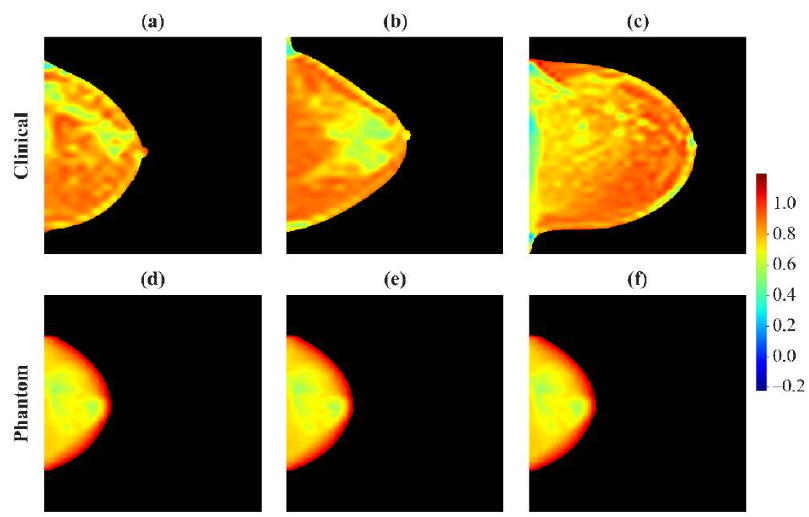
Figure 5. Heat maps for a robust feature (a Gabor Wavelet feature, CMV = 0.11) used as an example in Figure 1a. Top row: Clinical images at the ( a ) 5th, ( b ) 50th, and ( c ) 95th percentiles of the distribution in Figure 1a. Bottom row: Phantom images derived from various acquisition settings, corresponding to ( d ) left-most, ( e ) intermediate, and ( f ) right-most data points in Figure 1a. While there are clear differences between the three patients, the heat maps for the phantom are effectively identical. For the purposes of illustration, these figures are smoothed to avoid artifacts of pixelation.